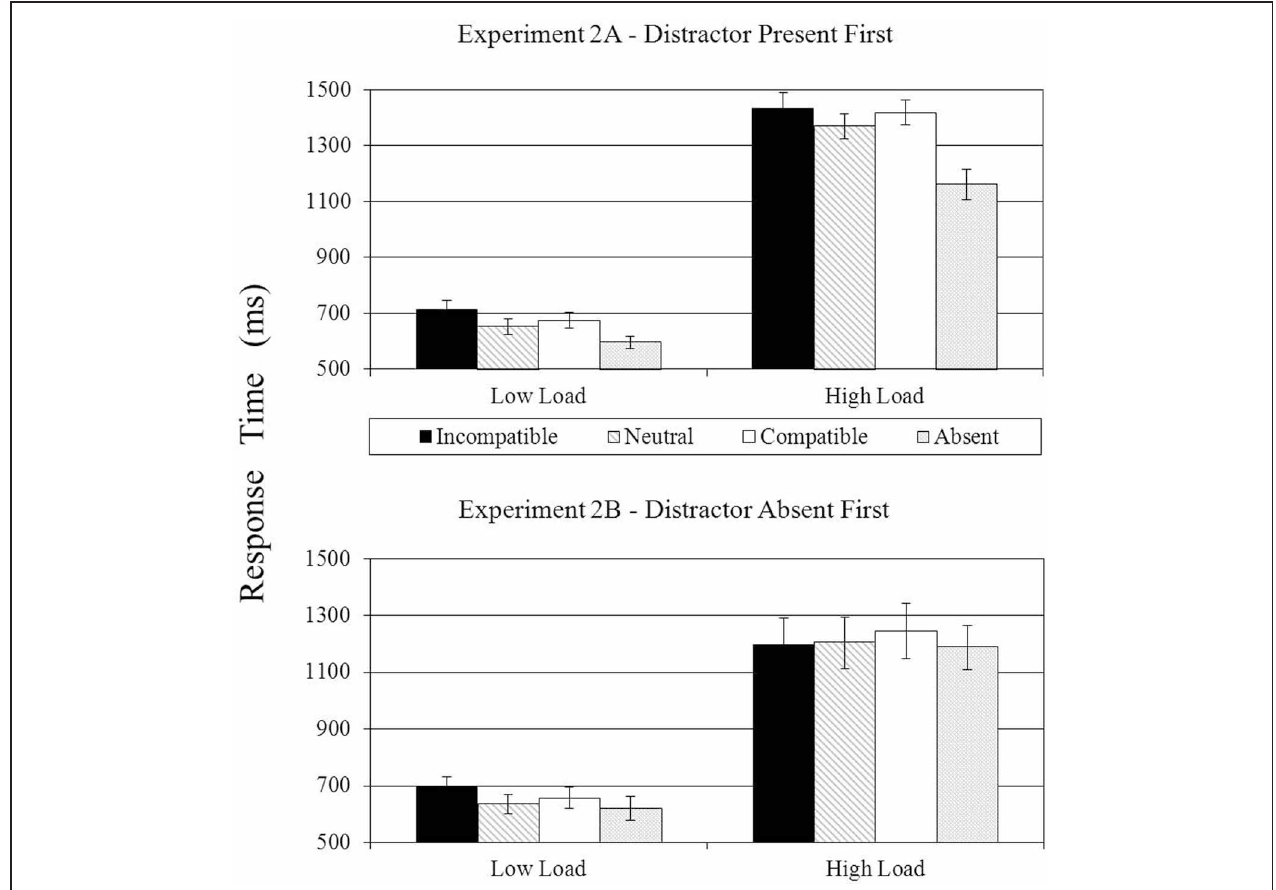
FIGURE 4 | Mean RTs (in ms) shown as a function perceptual load and distractor condition in Experiments 2A (top panel) and Experiment 2B (bottom panel). Error bars reflect the standard error of the